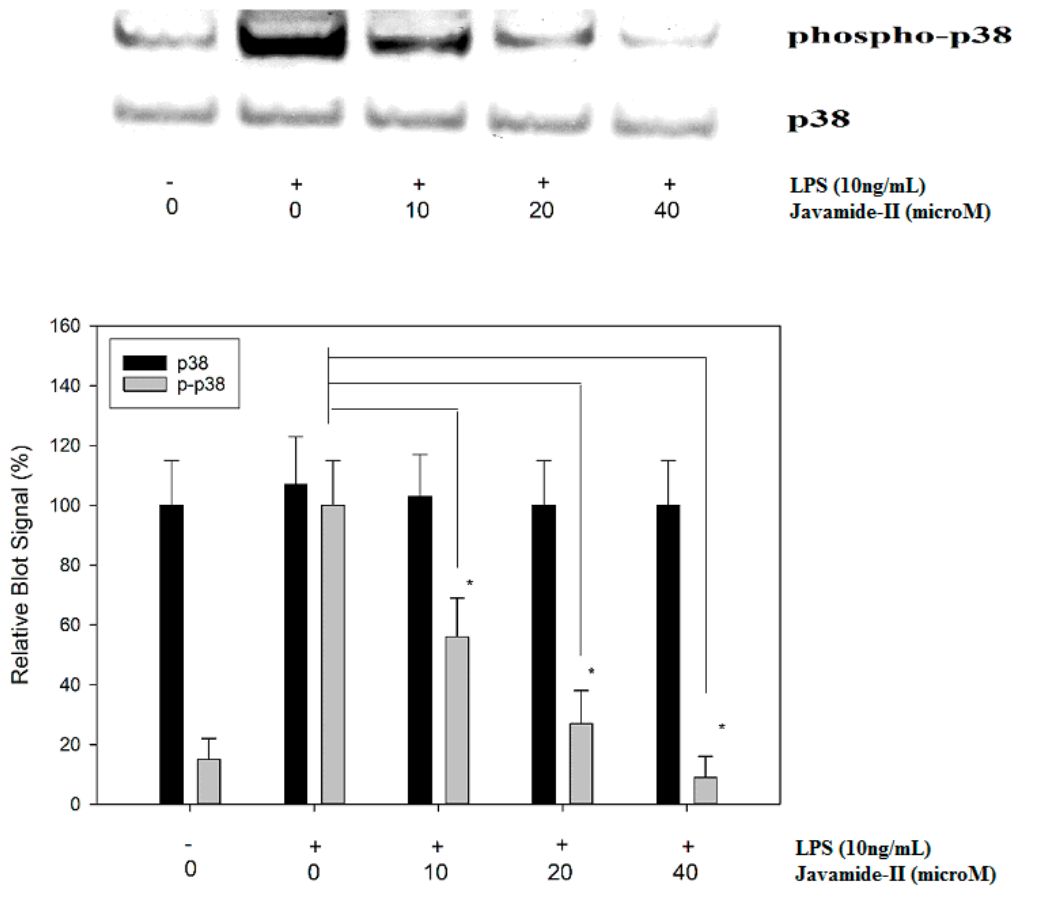
Figure 3. The effect of javamide-II on the phosphorylation of p38. The samples were prepared using PMA-differentiated THP-1 cells treated with javamide-II (0, 10, 20, 40 µM) followed by treatment with LPS for 45 min. Data points represent the means ± SD ( n = 5). The P value was calculated using one-way ANOVA with the Holm–Sidak method, and the asterisks (*) indicate significant differences ( P < 0.05) compared to the p38 control.